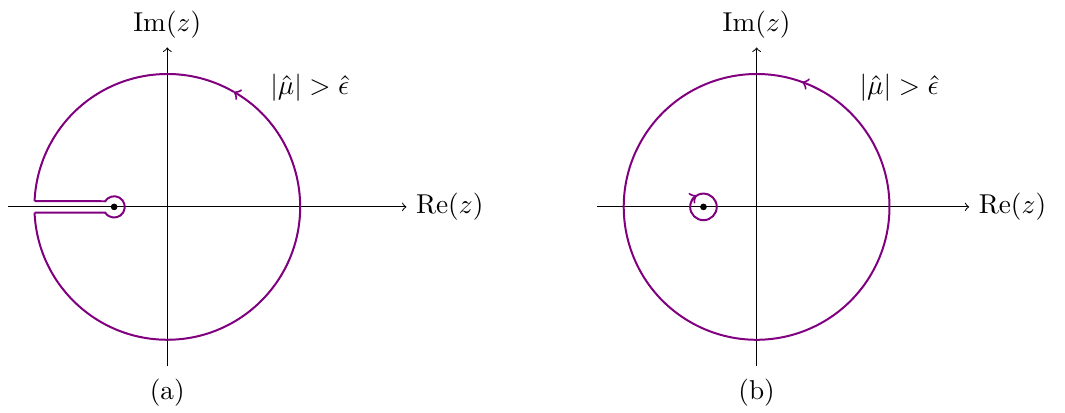
Figure 10 . Fermions: pole is at z = − e β ( (cid:15) − qµ ) and is denoted by the black dot on the -ve real axis. The big circle is the unit circle. The purple curve is the contour C 0 (counterclockwise) over which the holonomy is integrated